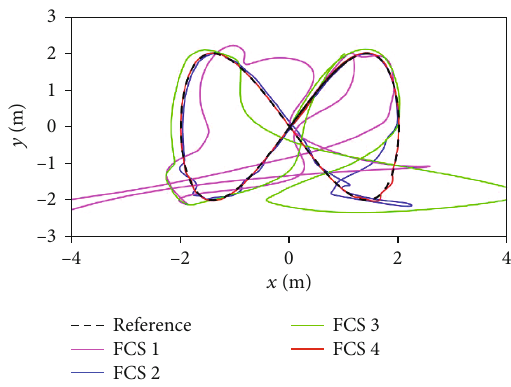
Figure 18: Evolution of the quadrotor ’ s trajectory in 2D ( x − y plane) for di ff erent fl ight control systems: fl ight scenario 2.